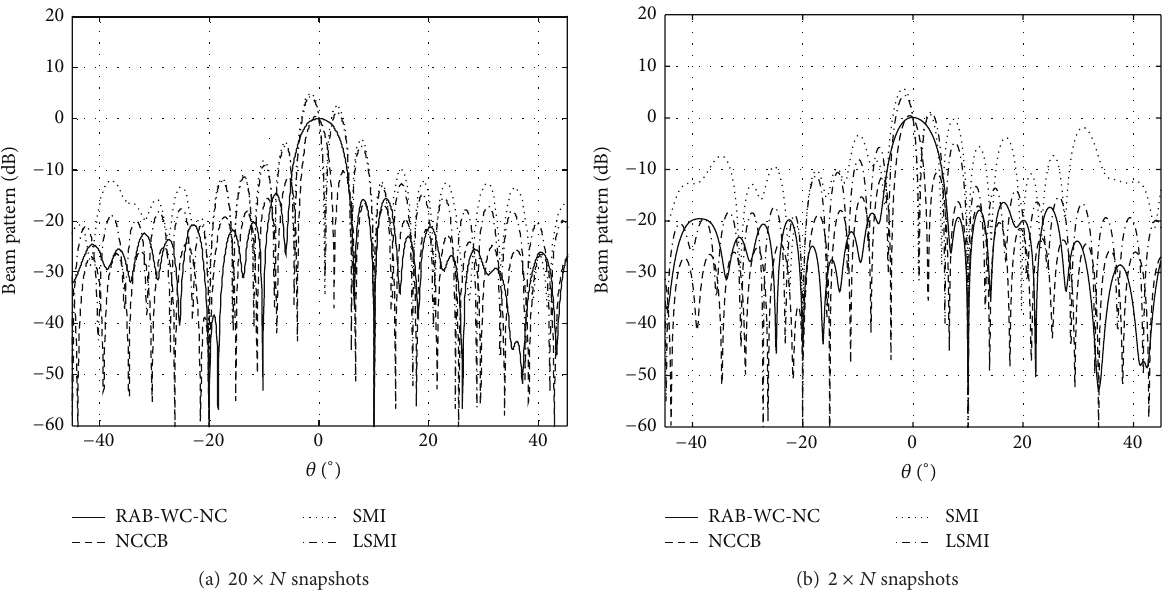
Figure 3: Various beamformers’ beam patterns with high